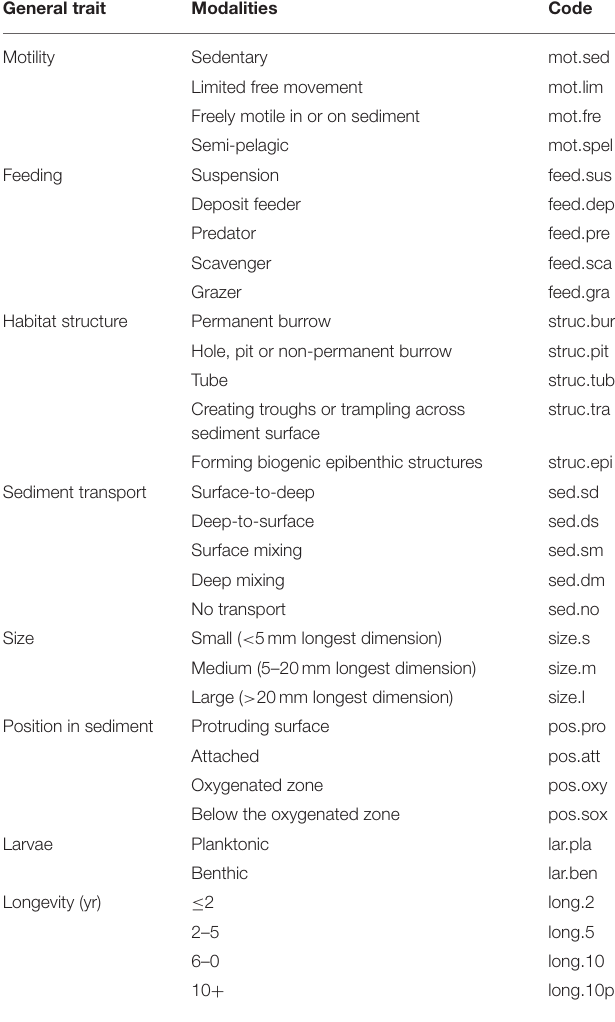
TABLE 2 | Biological traits used to describe functional structure of macrofauna